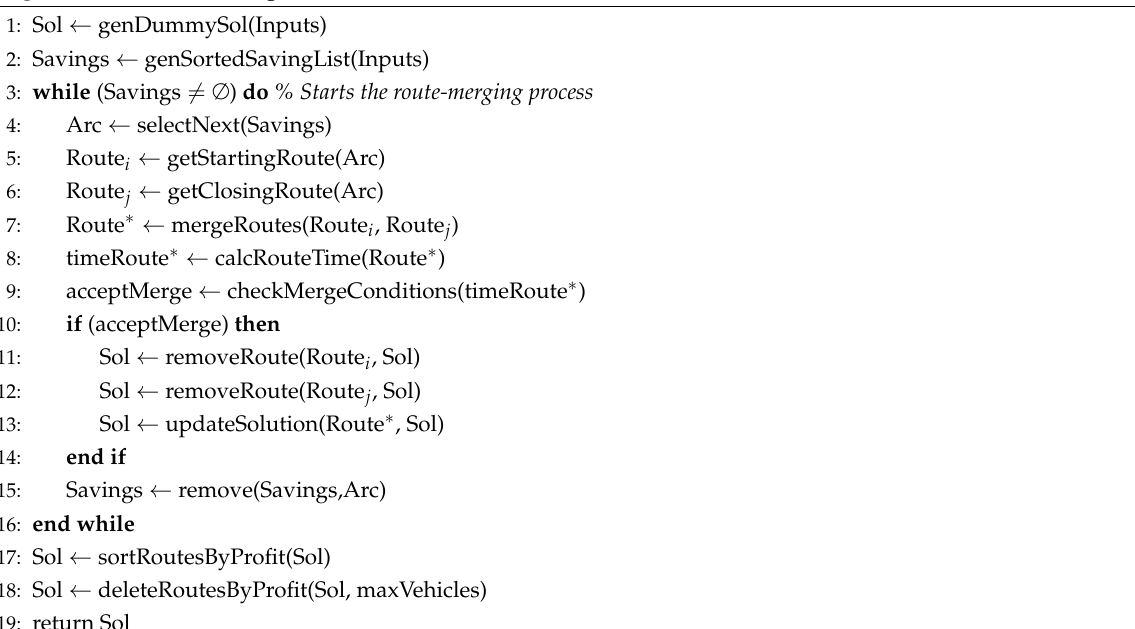
Algorithm 1 Heuristic algorithm for the deterministic